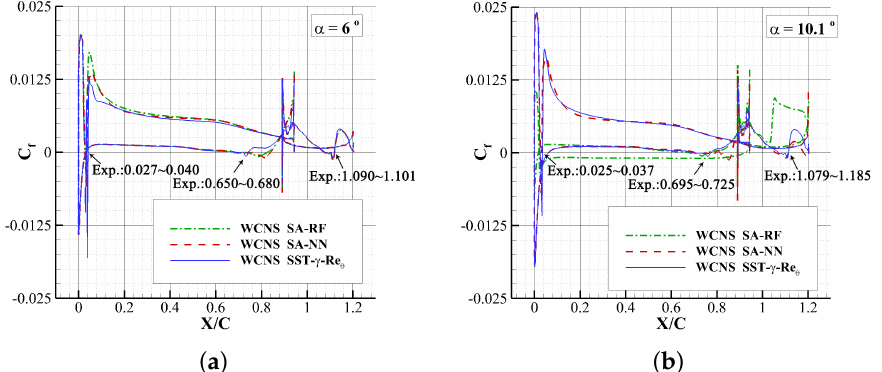
Figure 17. Drag coefficient distribution of the surface of NLR7301 airfoil. ( a ) a = 6 ◦ . ( b ) a = 10.1 ◦